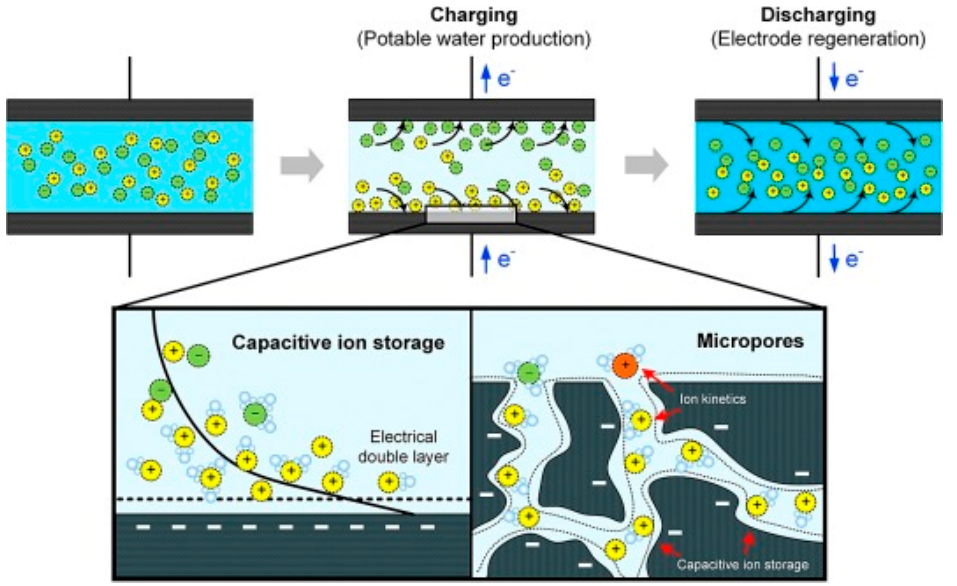
Figure 4. Scheme of the typical capacitive deionization (CDI) process for saline water purification. Reproduced from [139], with permission from Elsevier, 2018.